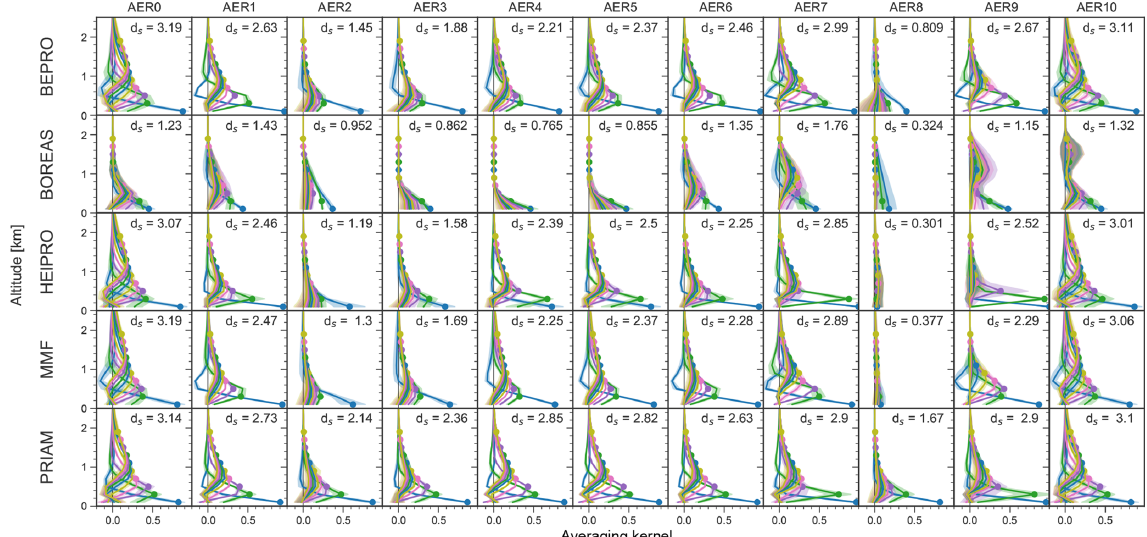
Figure 5. The 360nm aerosol AVKs. Each subplot shows the mean AVK over all SZAs and RAA for a specific aerosol scenario (columns) and retrieval algorithm (rows). Filled circles indicate the nominal altitude of the corresponding AVK plotted in the same colour. Colour- shaded areas (barely visible in most cases) indicate the standard deviation of the AVKs, i.e. the variation for different SZAs and RAA. Also shown are the DFS. AVKs stem from retrievals with noisy measurements